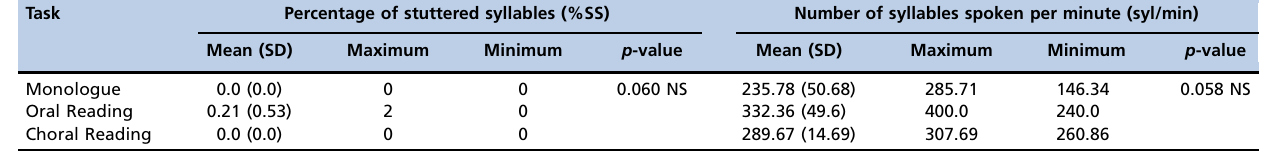
Table 2 - Description of speech fluency characteristics in each task for Group 2.